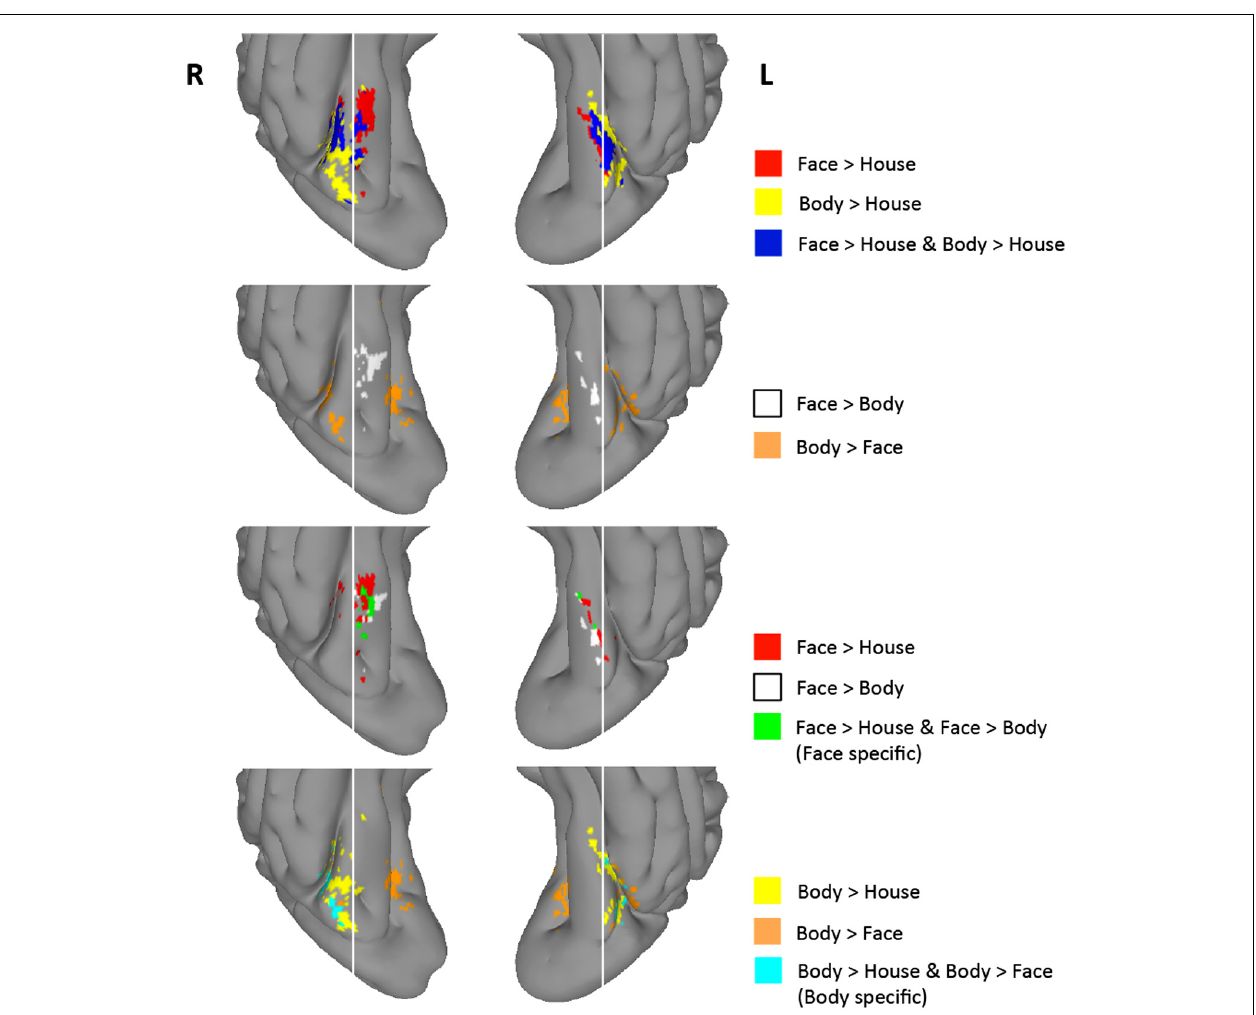
cyan). Lateral activations were also found in the body > house contrast, indicating that bodies evoked greater activation in the lateral regions (cyan) than both faces and houses.